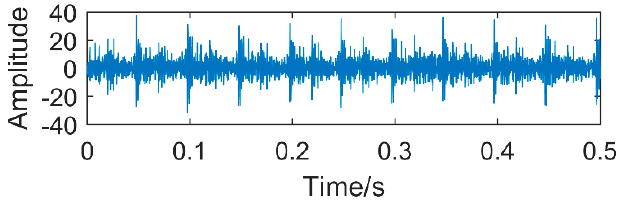
Figure 31. Frequency domain diagram of decomposition results obtained by EEMD.